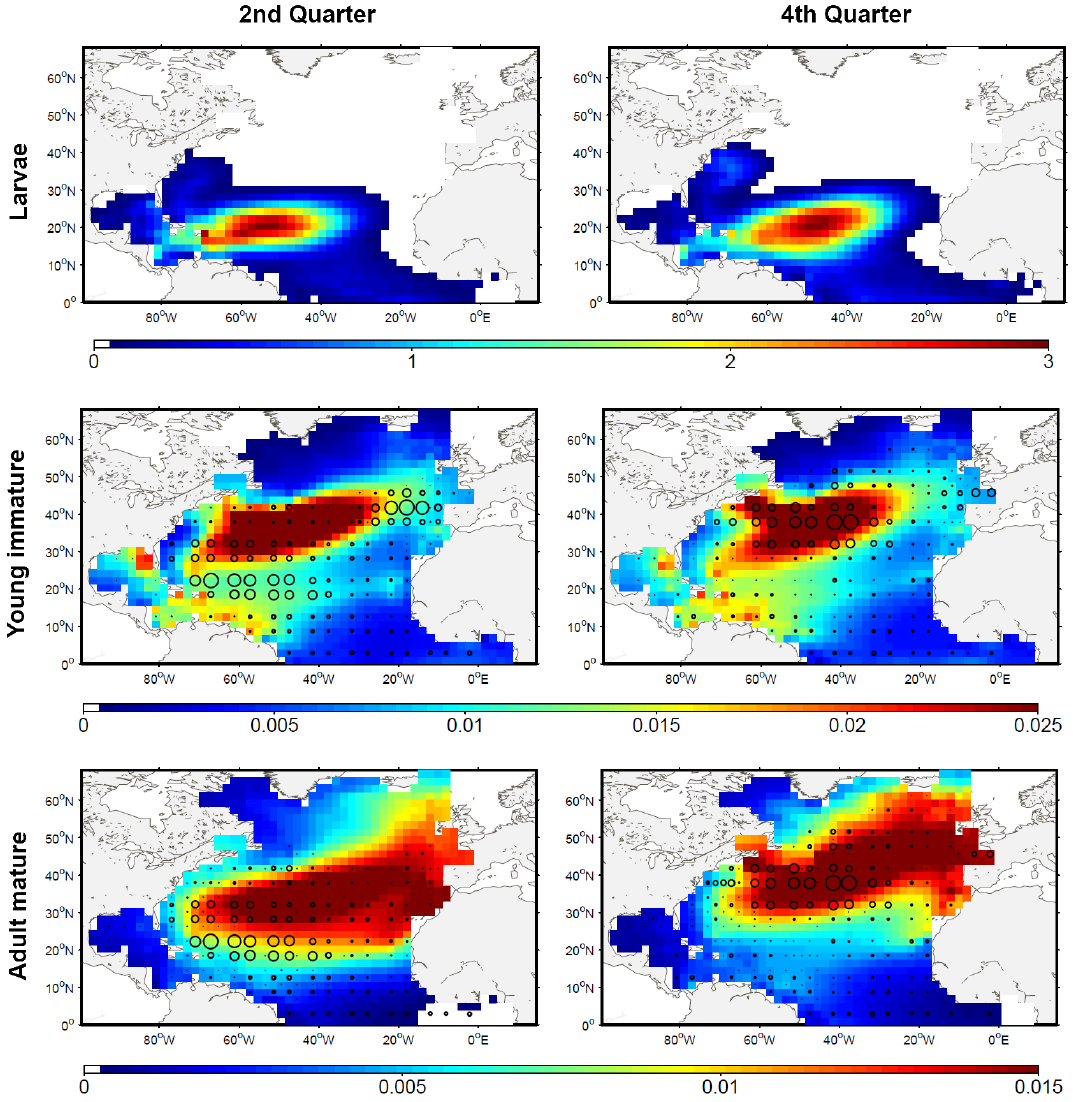
Figure 6. Seasonal average (1991–2000) distributions of North Atlantic albacore in the second (left) and fourth (right) quarter for larvae (no.km − 2 ) , young immature fish (gm − 2 ) and adult mature fish (gm − 2 ) . Circles are proportional to observed catch. Fisheries selecting small size fish (<85cm, T10 to B13) are superimposed on young fish distributions, and those selecting large size fish (>85cm, L1 to L9) on adult fish